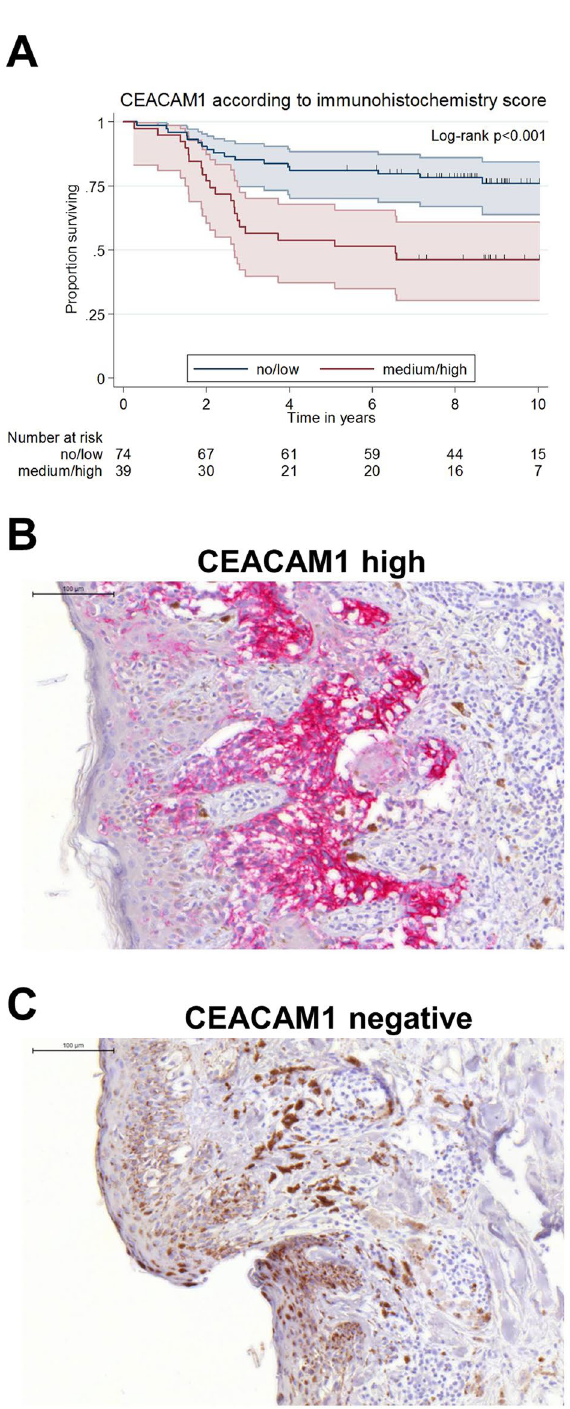
Figure 4. CEACAM1 expression in melanoma is inversely correlated with patient survival. ( A ) Kaplan-Meier overall-survival analysis (OS): CEACAM1 expression in melanoma samples was visualized by CEACAM1 specific immunohistochemistry in melanoma samples from 113 patients. Patients were grouped as CEACM1 “no/low” staining or CEACAM1 “medium/high” staining. CEACAM “no/low” patients show a significantly longer overall survival than CEACAM “medium/high” patients (p < 0.001). ( B ) A melanoma with high CEACAM1 expression: Immunohistochemical staining of paraffin embedded patient tissue for CEACAM1. ( C ) A CEACAM1 negative melanoma: Immunohistochemical staining of paraffin embedded patient tissue for